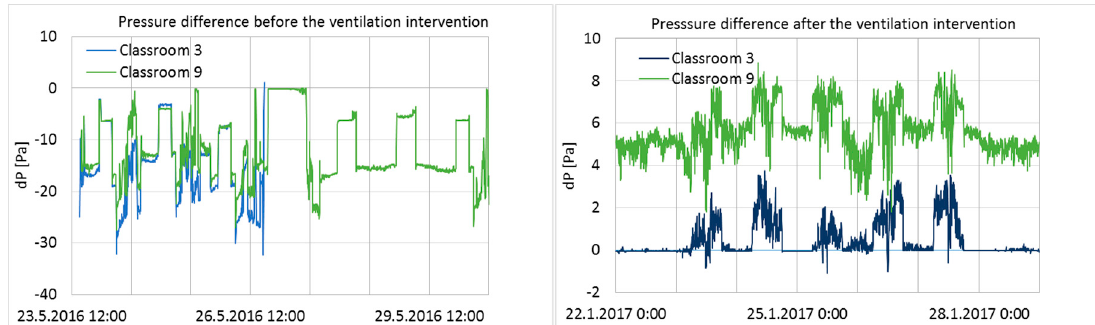
Figure 3. One ‐ week pressure difference across the building envelope in Classrooms 3 and 9 before and after the ventilation intervention. In Classroom 3, the results before intervention were recorded only for half of the week because of dysfunction of the measurement device.